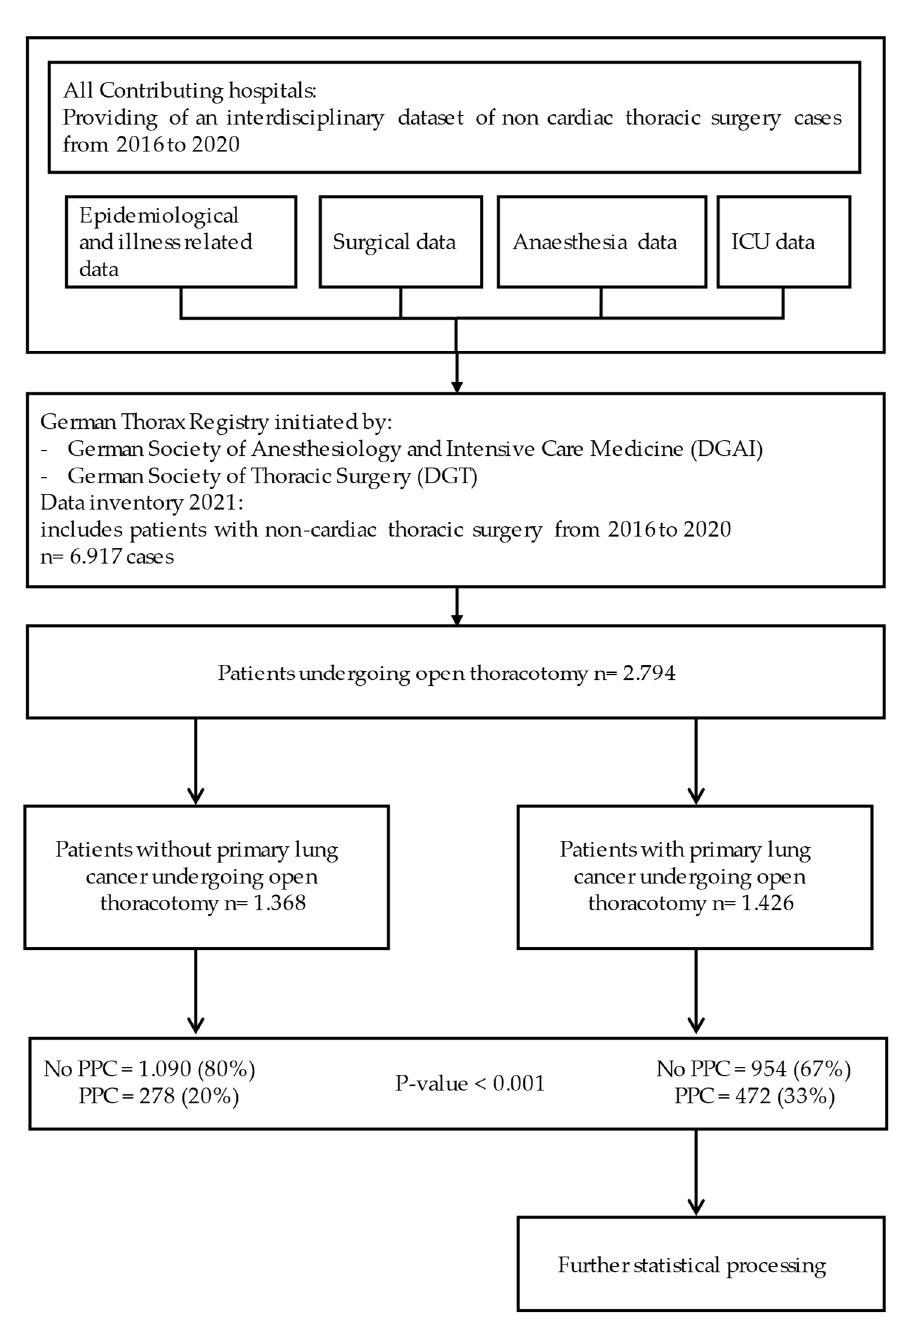
Figure 1. Case selection, study design, and entity-related PPC incidence. Data are presented as num- bers of patients (percentage). PPC = postoperative pulmonary complications, ICU = intensive care unit, DGAI = German Society of Anaesthesiology and Intensive Care Medicine, DGT = German So- ciety for Thoracic Surgery.